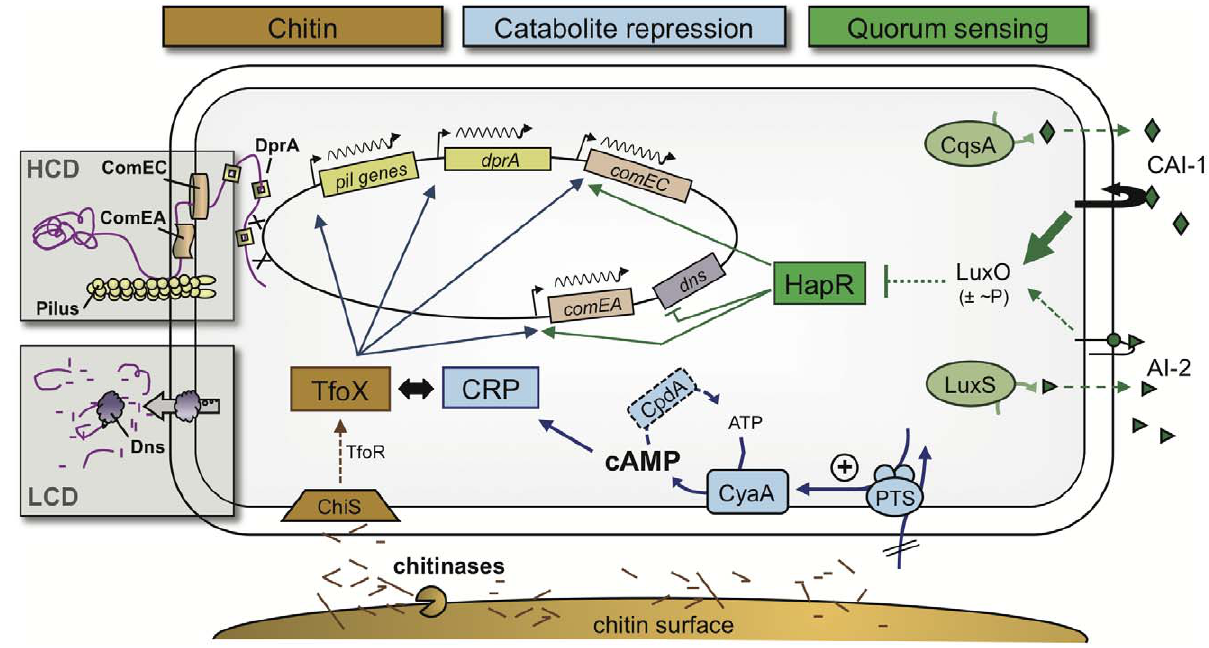
Figure 7. Model of the regulatory network of natural competence and transformation of V.cholerae . At least three extracellular and intracellular signaling molecules must be present to allow natural transformation to occur in V. cholerae . 1) Chitin degradation products such as chitin oligomers, which lead to the induction of the sRNA TfoR and the main regulator of transformation TfoX (chitin pathway shown in brown). 2) The secondary messenger cAMP, which has to accumulate within cells (CCR pathway shown in blue). 3) Extracellular autoinducers, with an emphasis on the stronger autoinducer CAI-1, which feed into the quorum-sensing circuit (shown in green). Whereas chitin- and TfoX-dependent induction and the requirement for cAMP and CRP are universal for all, so far investigated, competence genes, the QS-dependent circuit regulates only a subset of those, such as comEA and comEC . Therefore, QS acts as a switch in gene expression and is responsible for the final fate of the surrounding DNA (boxed areas). At a low cell density (LCD), the DNA (shown in purple) is degraded by the nuclease Dns. As a consequence, the cells are non-transformable. At a high cell density (HCD) and, therefore, high abundance of the autoinducer CAI-1, the nuclease gene dns is transcriptionally repressed, whereas comEA and comEC are activated. ComEA as well as ComEC then contribute to the DNA uptake process, probably due to their ability to shuffle the DNA through the periplasmic space and the inner membrane, respectively.